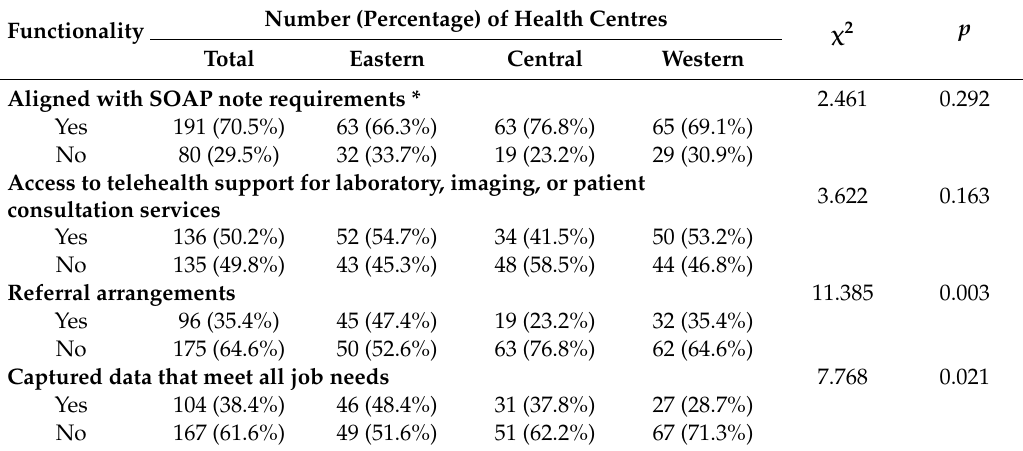
Table 2. Functionality of electronic medical records adopted by the community / township health centres ( n =